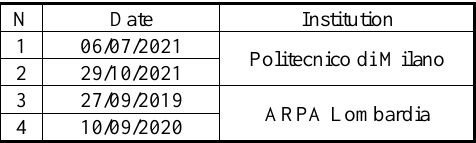
Table 1. List of the observation